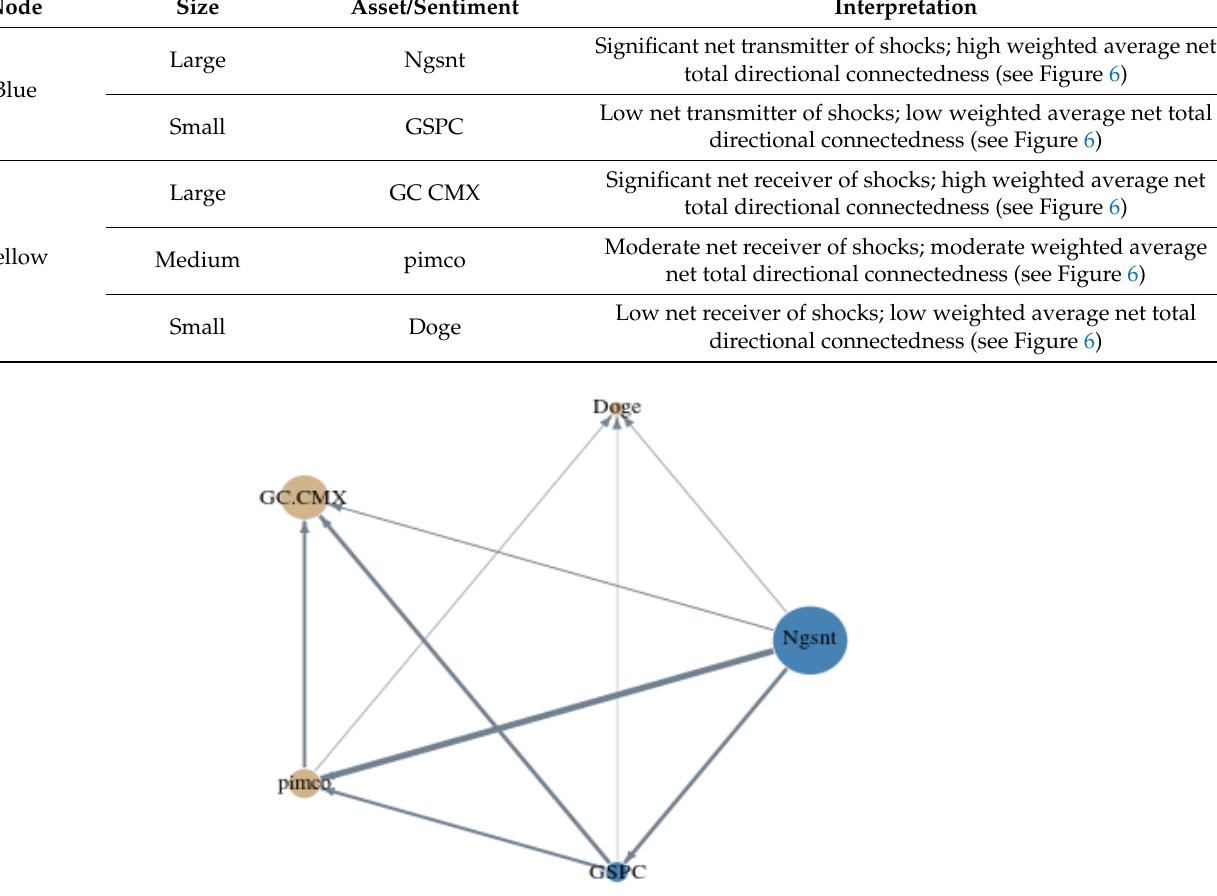
Figure 6. Network plot analysis depicting the net emitter of shocks (blue) and the net receiver of shocks (yellow).